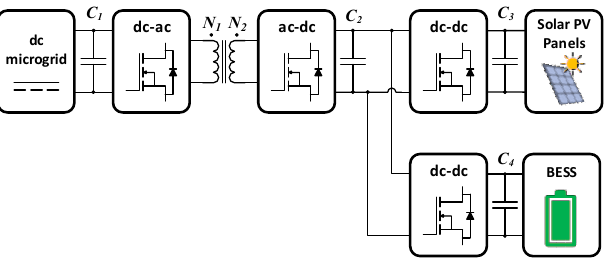
Figure 1. Proposed topology for the unified power converter.